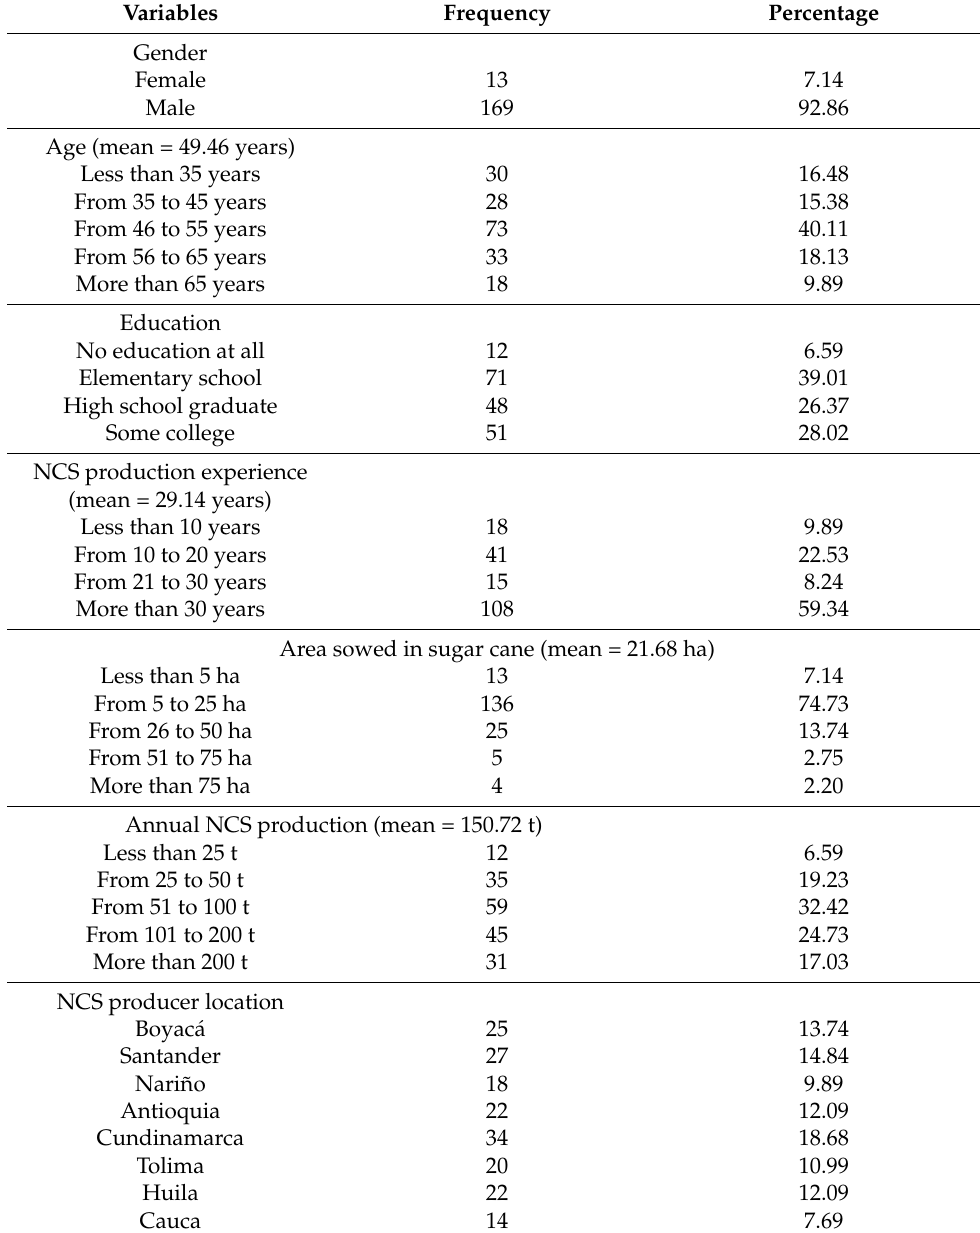
Table 1. Demographic attributes of the respondents ( N =